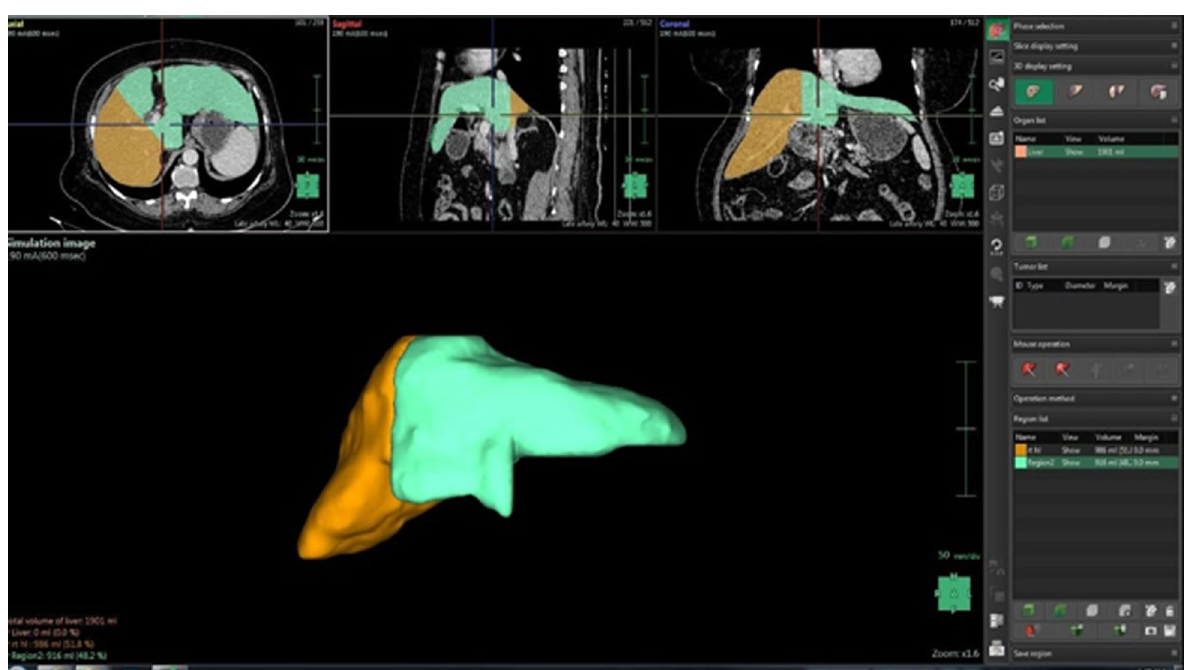
Fig. 2 Liver volumetry was done in the portal venous phase. The left lobe is colored green and the right lobe is colored yellow